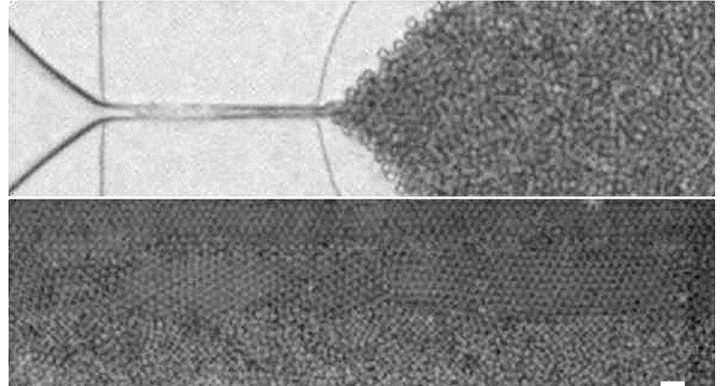
Figure 8. Optical microscopic images of the microdroplets generation and assembly multiple-layer configuration of the functional fluidic material system. The water phase was 15 wt % NIPAM aqueous solution mixed with 3.0 wt % MBA and 1.5 wt % I 2959, and the oil phase was hexadecane contained 2.7% ( w/v ) Span80. Q o and Q w were 150 and 20 μ L·h − 1 , respectively. The microfluidic device dimensions were w f = 25 μ m, d c = 40 μ m and W a = 400 μ m. The scale bar is 50 μ m.